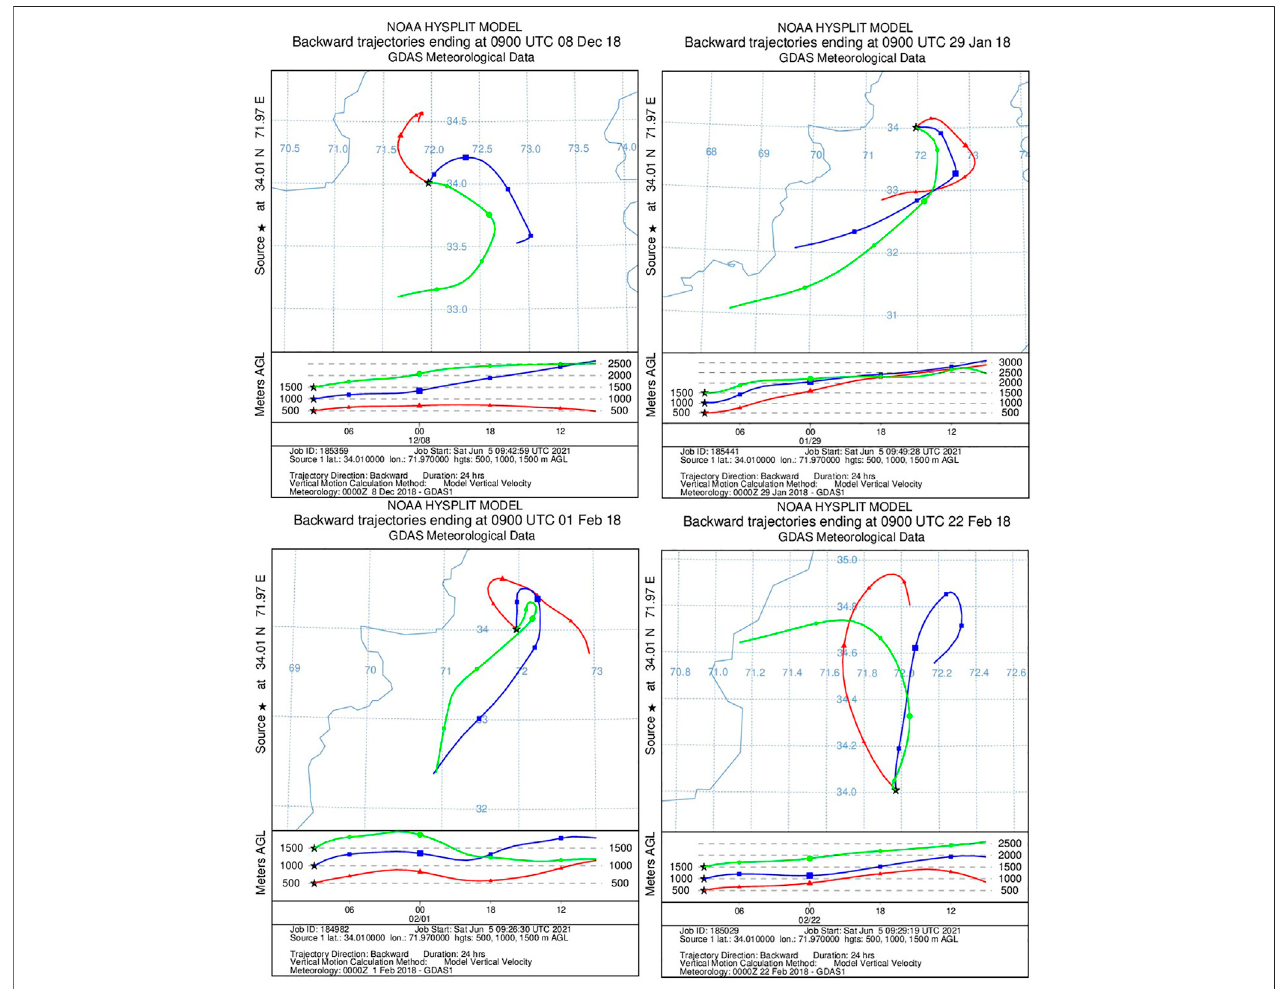
FIGURE8| Five-dayairmassbacktrajectoriesduringthewinterseason(December,January,andFebruary),calculatedforthreeheights(500,1,000,and1,500 m) above the ground level indicating short trajectories from localized sources.